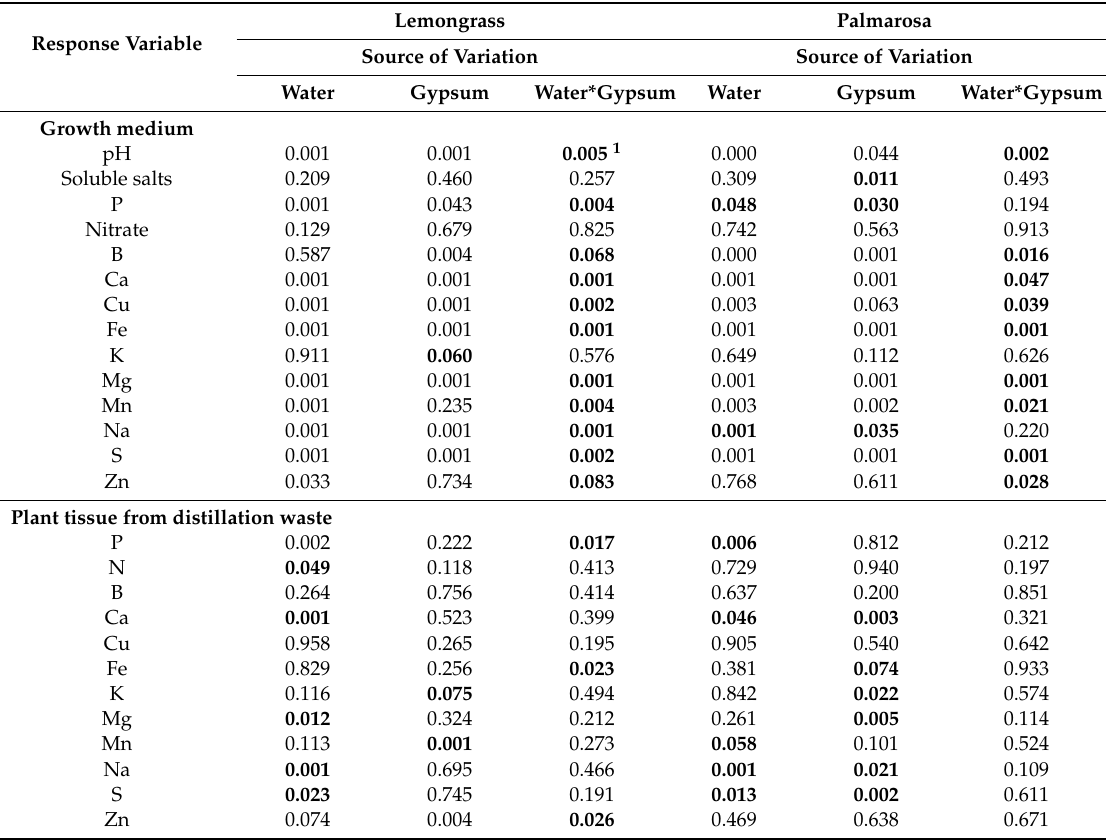
1 p -values shown in bold face indicate significance of the e ff ects that need multiple means